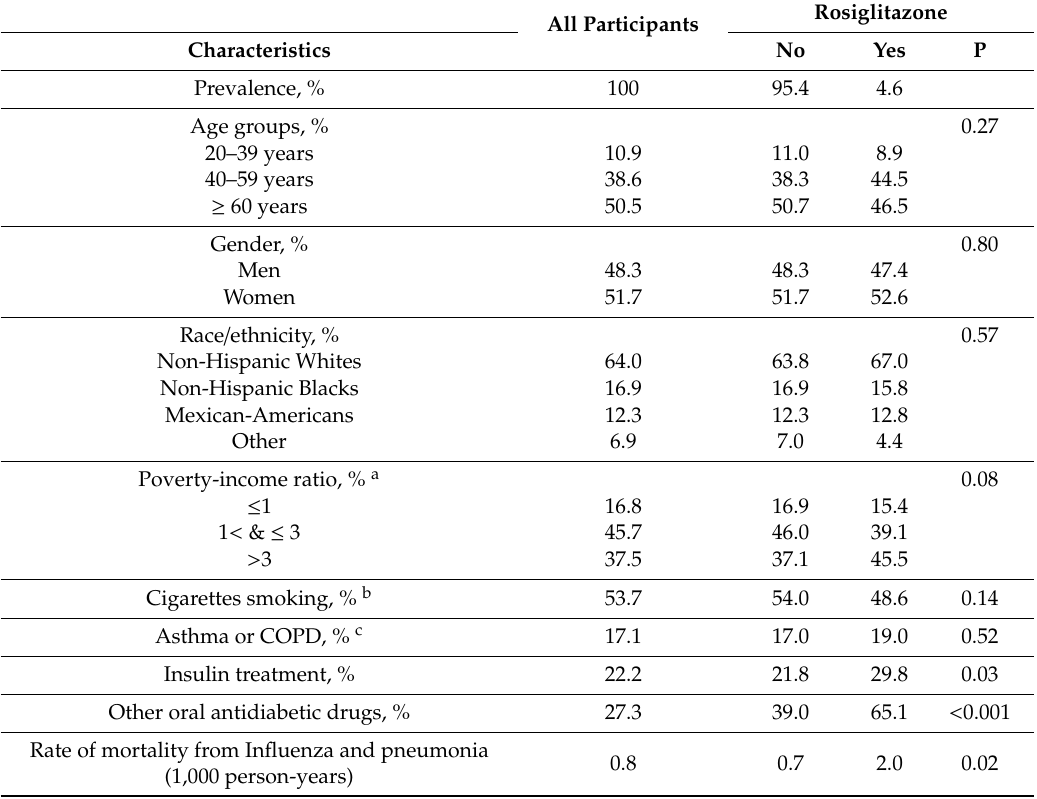
Table 1. Baseline characteristics of the study participants ( N = 6,600).